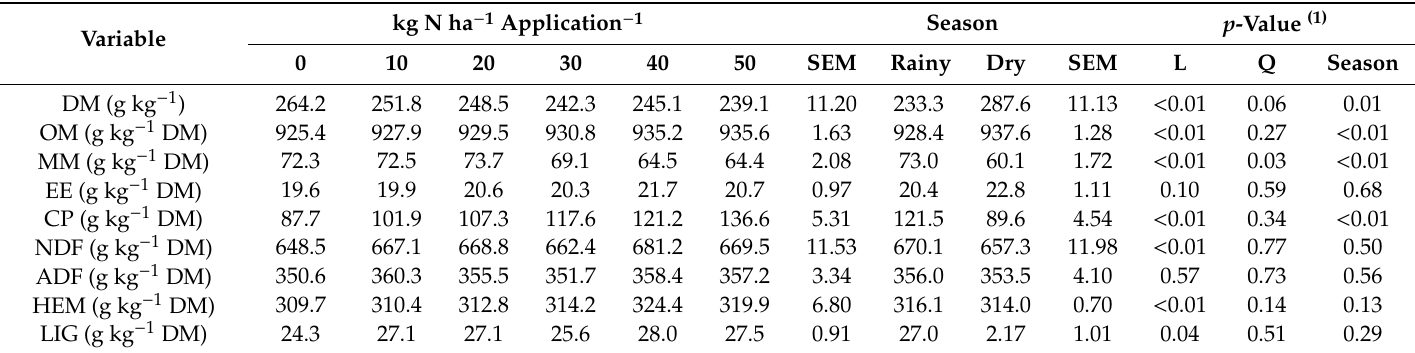
Table 4. Chemical composition of Guinea